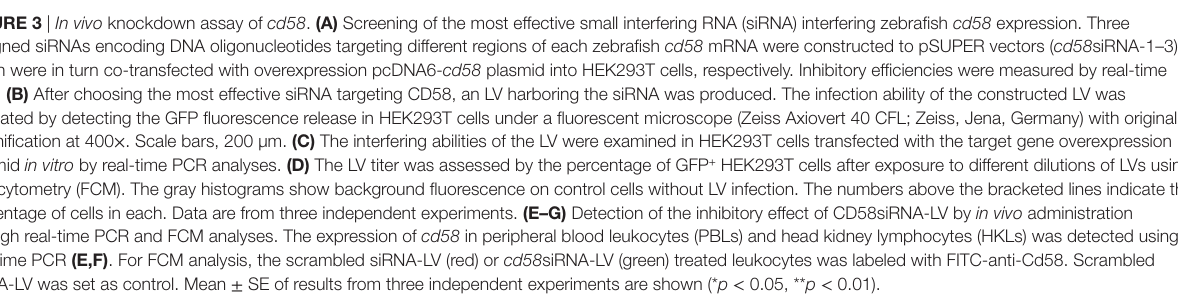
FigUre 3 | In vivo knockdown assay of cd58 . (a) Screening of the most effective small interfering RNA (siRNA) interfering zebrafish cd58 expression. Three designed siRNAs encoding DNA oligonucleotides targeting different regions of each zebrafish cd58 mRNA were constructed to pSUPER vectors ( cd58 siRNA-1–3), which were in turn co-transfected with overexpression pcDNA6- cd58 plasmid into HEK293T cells, respectively. Inhibitory efficiencies were measured by real-time PCR. (B) After choosing the most effective siRNA targeting CD58, an LV harboring the siRNA was produced. The infection ability of the constructed LV was evaluated by detecting the GFP fluorescence release in HEK293T cells under a fluorescent microscope (Zeiss Axiovert 40 CFL; Zeiss, Jena, Germany) with original magnification at 400 × . Scale bars, 200 µm. (c) The interfering abilities of the LV were examined in HEK293T cells transfected with the target gene overexpression plasmid in vitro by real-time PCR analyses. (D) The LV titer was assessed by the percentage of GFP + HEK293T cells after exposure to different dilutions of LVs using flow cytometry (FCM). The gray histograms show background fluorescence on control cells without LV infection. The numbers above the bracketed lines indicate the percentage of cells in each. Data are from three independent experiments. (e–g) Detection of the inhibitory effect of CD58siRNA-LV by in vivo administration through real-time PCR and FCM analyses. The expression of cd58 in peripheral blood leukocytes (PBLs) and head kidney lymphocytes (HKLs) was detected using real-time PCR (e,F) . For FCM analysis, the scrambled siRNA-LV (red) or cd58 siRNA-LV (green) treated leukocytes was labeled with FITC-anti-Cd58. Scrambled siRNA-LV was set as control. Mean ± SE of results from three independent experiments are shown (* p < 0.05, ** p <